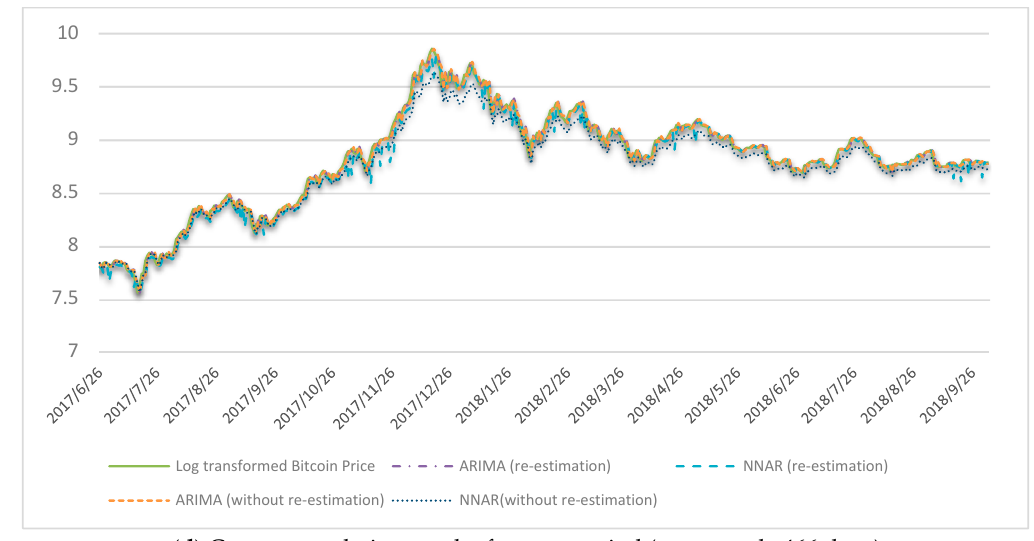
Figure 4. Bitcoin price forecast. ( a , b ) refer to the first training and test samples forecast in comprehensive and concentrated view, respectively, and ( c , d ) refer to the second training and test samples forecast in comprehensive and concentrated view, respectively.